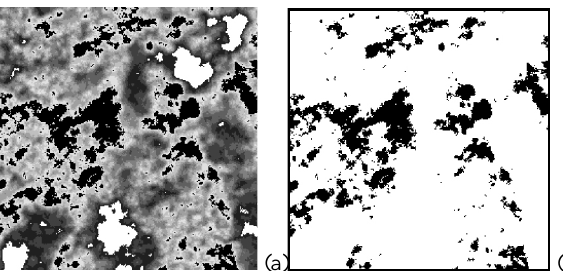
Fig. 5. The obtained results for the SOM method: (a) the image segmented with nine clusters; and (b) the binary image obtained from the segmentation process, where 0 value corresponds to the pore space class and 1 value corresponds to the soil solid